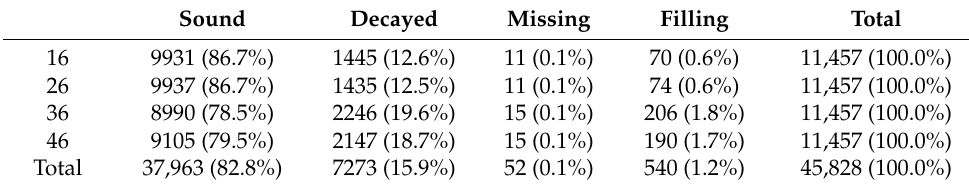
Table 3 indicates the status of sound, decayed, missing and filled PFMs by the tooth number. There was a statistically significant difference between the PFMs 16, 26, 36 and 46 regarding the number of sound, decayed, missing and restored PFMs ( p < 0.001). Only the PFMs in the same jaw (maxilla or mandible) showed a similar distribution regarding the number of sound, decayed, missing and restored PFMs ( p > 0.05). Compared to the high number of sound PFMs in the maxilla, high numbers of decayed ( p < 0.001) and restored ( p < 0.001) PFMs in the mandible created a statistically significant difference. There was a statistically significant difference due to the f/d ratio of the maxillary PFMs, which was almost twice as the rate of mandibular PFMs ( p < 0.001). Table 3. Status of sound, decayed, missing and filled PFMs by the tooth number [n (%)].